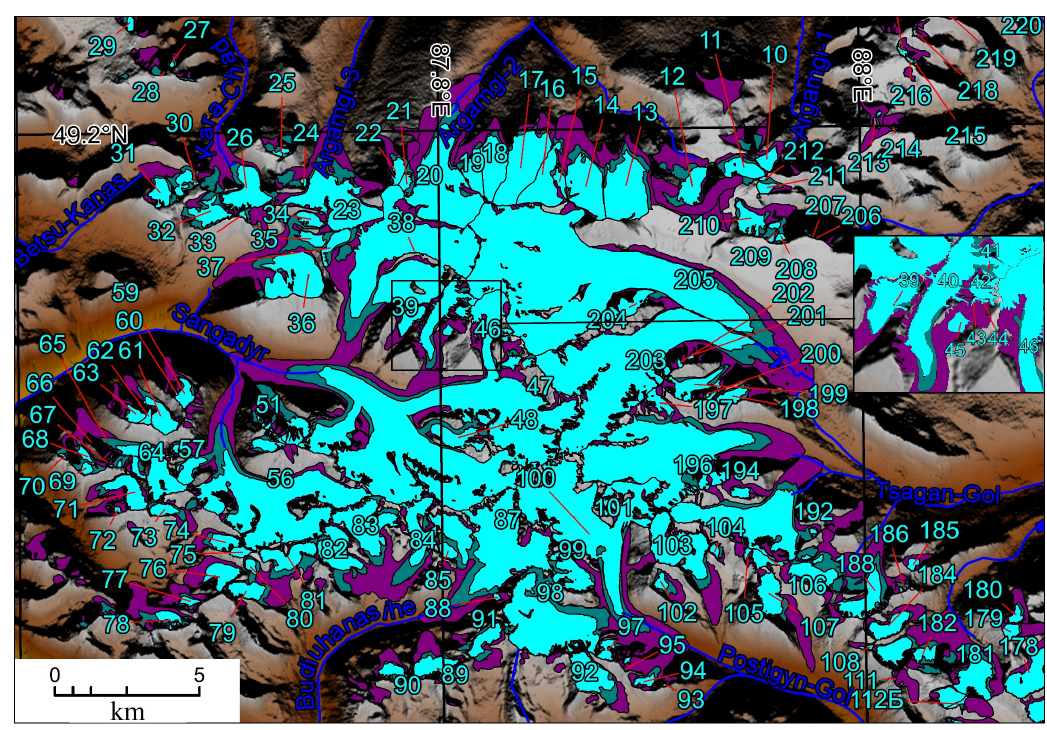
Figure 13. Glacial shrinkage after the LIA maximum in the central part of Tavan Bogd.